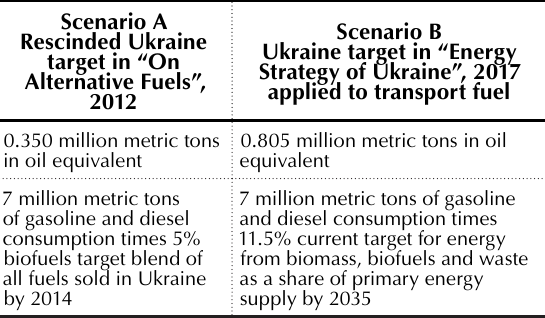
Table 1. Biofuels production in the period 2010–2016 (thousand tons of oil